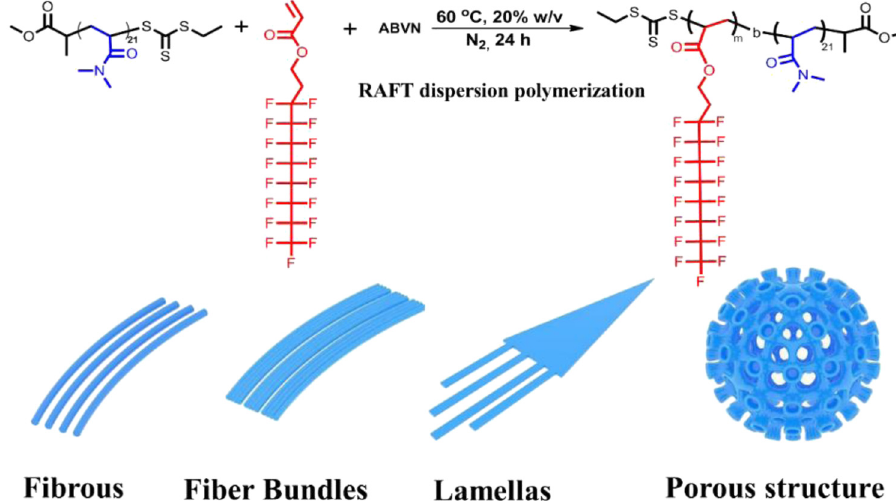
Scheme 1: RAFT - PISA progress of SFLC BCPs via chain extension of PDMA 21 macro -